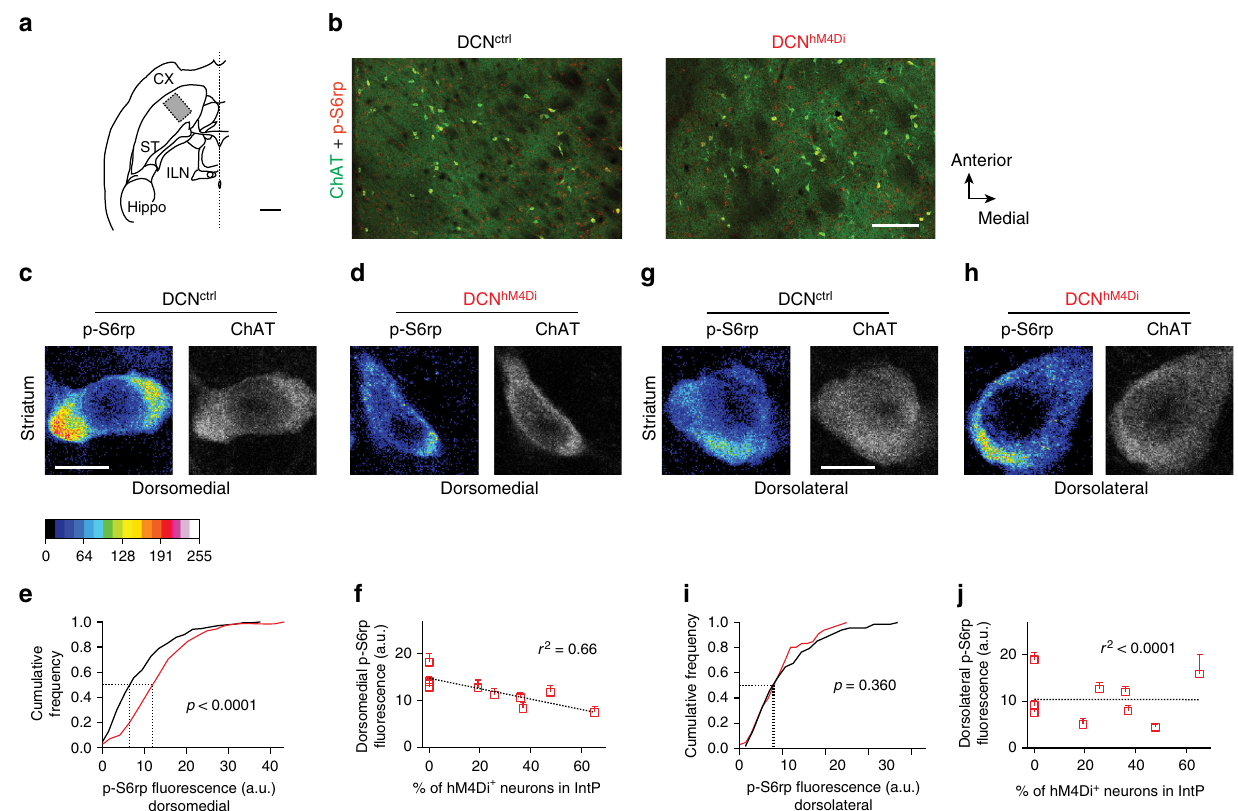
Fig. 5 Impact of DCN silencing on ChAT interneuron activity in the striatum. a Schematic for overview images from dorsal striatum in horizontal sections. The square indicates the location of the image in ( b ). Anatomical annotations: CT cortex, ST striatum, ILN intralaminar thalamic nuclei, Hippo hippocampus. b Example overview image containing parts of dorsomedial and dorsolateral striatum from CNO-injected control mice and mice expressing hM4Di in the DCN of both hemispheres. ChAT immunoreactivity in green, p-S6rp immunoreactivity in red. Scale bar: 200 µ m. c , d Examples of dorsomedial striatal ChAT interneurons stained with anti-ChAT and anti-p-S6rp antibodies. Medial and interposed DCN of vGluT2-cre mice were bilaterally injected at P18 with AAV2-DiO-hM4Di and mice were intra-peritoneal (i.p.) injected with CNO (2.5 mg/kg) 50 min before analysis. Immune reactivity was examined at P35 in the dorsomedial striatum DCN ctrl (control) and DCN hM4Di mouse brains. A 16-pseudocolor palette (Lookup Table) highlights the intensity of p-S6rp signal. Scale bar: 10 µ m. e Cumulative frequency of p-S6rp fl uorescence intensity in dorsomedial striatal ChAT neurons ( n = 242 ChAT-positive neurons from N = 3 DCN hM4Di mice and from N = 3 control mice, p < 0.0001, Kolmogorov – Smirnov test). f p-S6rp signal intensity in dorsomedial ChAT-positive neurons in one hemisphere correlates with the percentage of hM4Di-expressing cells in the contralateral interposed deep cerebellar nucleus. Mice were bilaterally injected in the DCN. The infection rate in the DCN of each hemisphere was correlated with the p-S6rp immunereactvity in the contralateral striatum ( r 2 = 0.66, n = 242 ChAT-positive neurons across six hemispheres from N = 3 DCN hM4Di mice and N = 3 control mice without DCN injection). Boxes display and error bars display mean ± SEM). g , h As in ( b , c ), but analyzing p-S6rp immune reactivity in the dorsolateral striatum. Scale bar: 10 µ m. i Cumulative frequency of p-S6rp fl uorescence intensity in dorsolateral striatal ChAT-positive neurons ( n = 134 ChAT-positive neurons from N = 3 DCN hM4Di mice and N = 3 control mice, p = 0.297, Kolmogorov – Smirnov test). j p-S6rp signal intensity in dorsolateral ChAT-positive neurons show no signi fi cant correlation to the percentage of hM4Di-expressing cells in the contralateral interposed deep cerebellar nucleus ( r 2 < 0.0001, n = 134 ChAT-positive neurons across six hemispheres of N = 3 DCN hM4Di mice and N = 3 control mice, boxes display and error bars